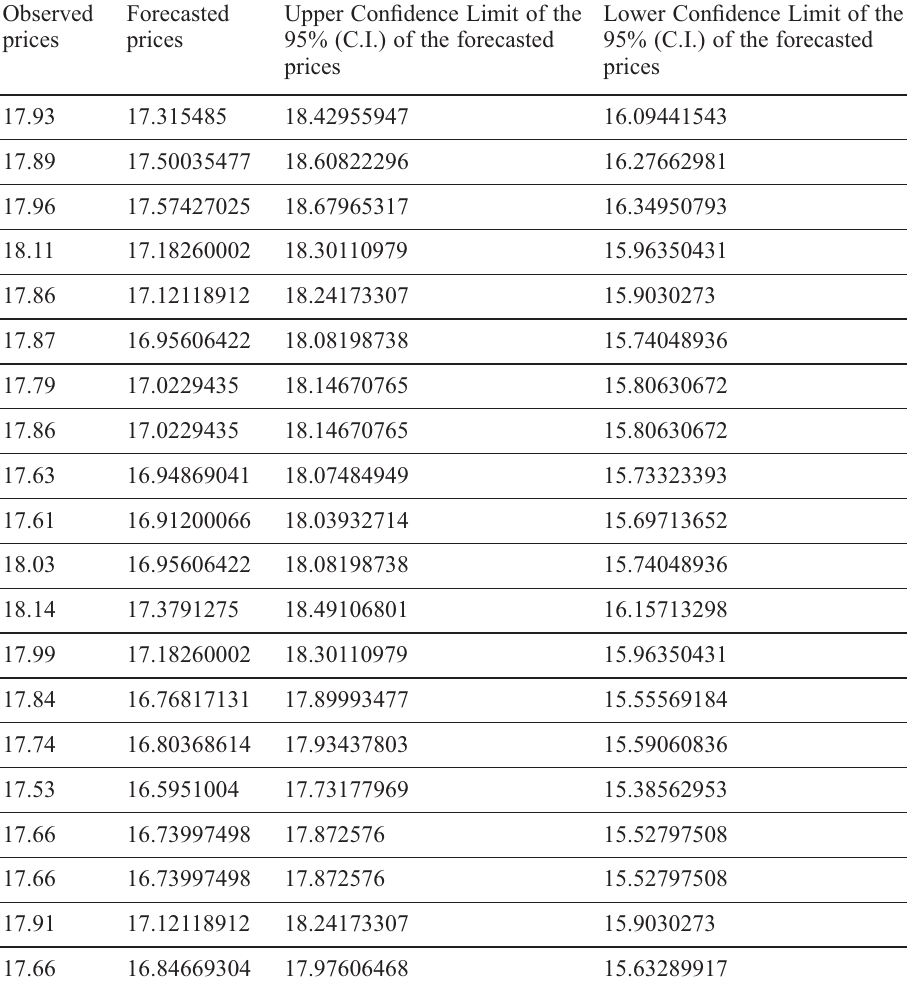
Table 1. Forecasted prices Alpha Bank stock, Upper Confi dence Limit (UCL) and the